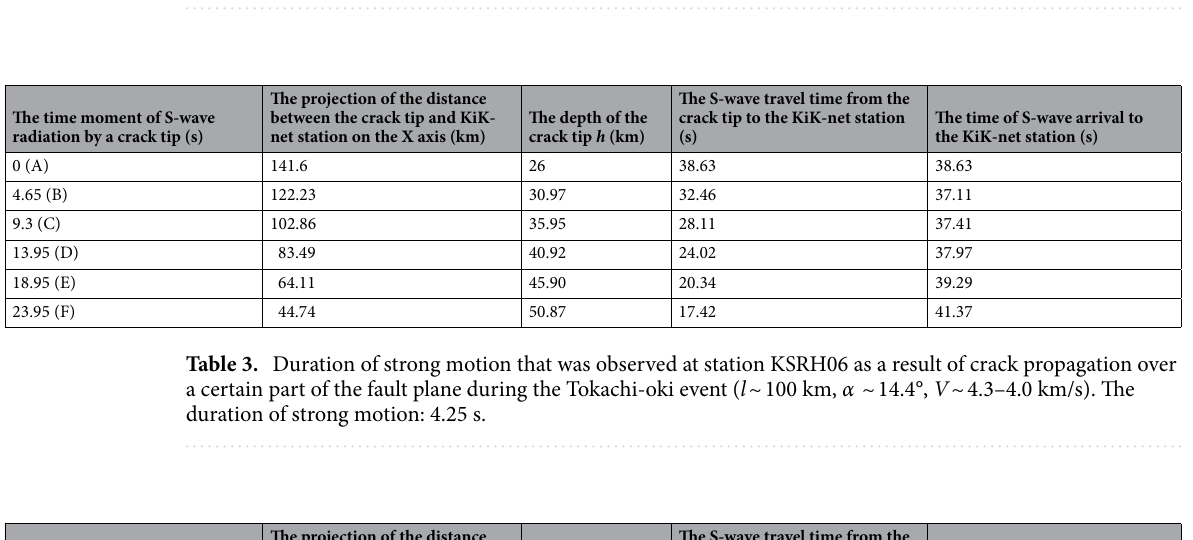
Table 2. Duration of strong motion that was observed at station KSRH09 as a result of crack propagation over a certain part of the fault plane during the Tokachi-oki event ( l ~ 100 km, α ~ 17.8°, V ~ 4.3–4.0 km/s). The duration of strong motion: 7.52 s.